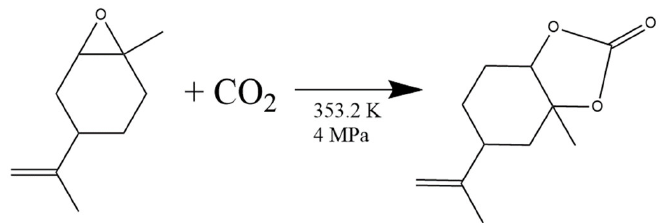
Figure 12. Synthesis of cyclic carbonates from CO 2 and